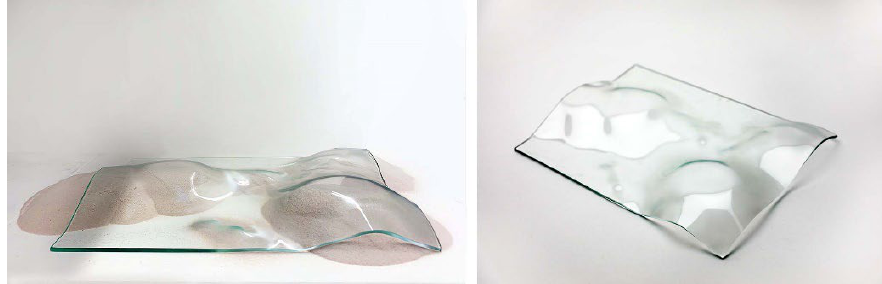
Fig. 3: Example of double curved glass pane shaped on top of silica